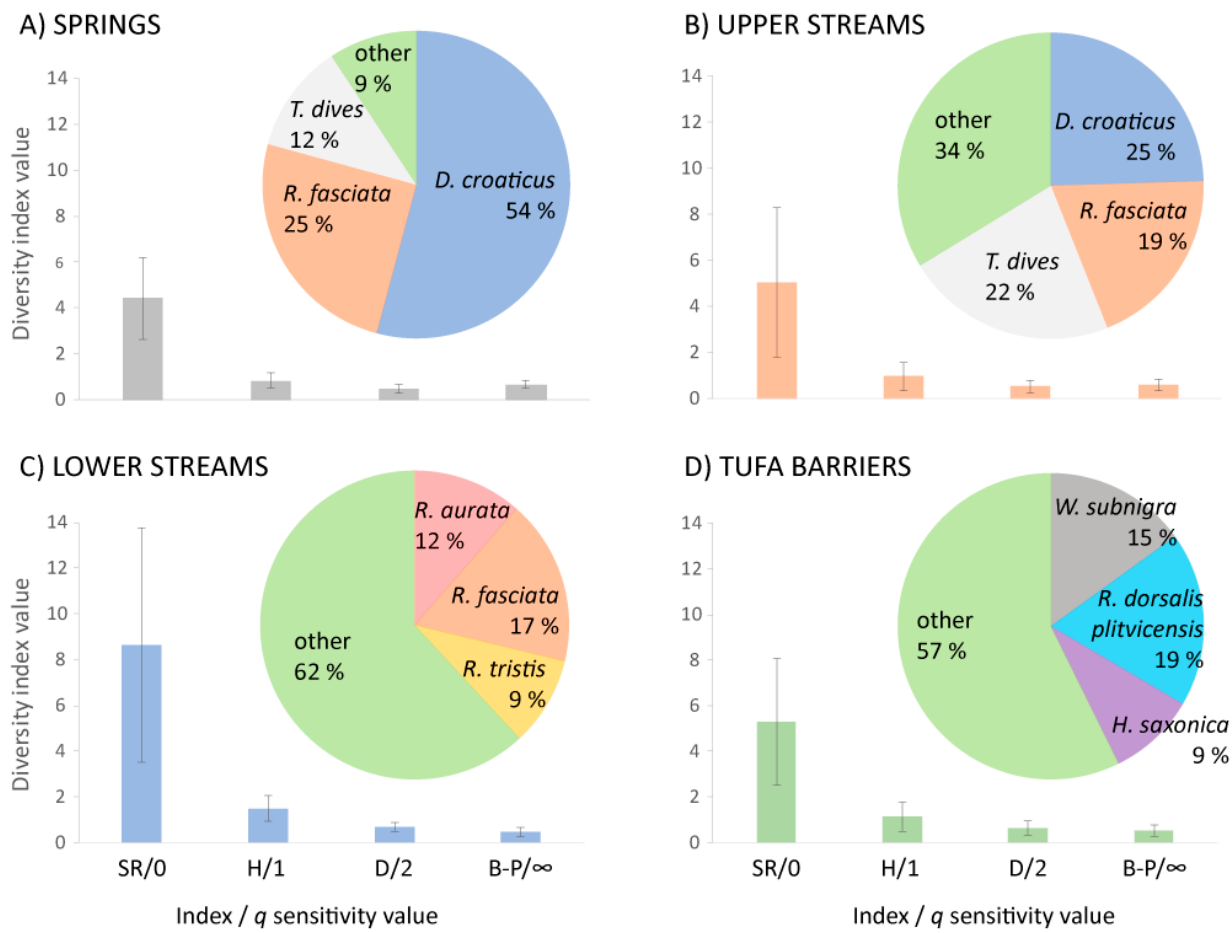
Figure 3. “Classical” (i.e., most commonly used) similarity profiles with values (average ± SD) of familiar diversity indices on a disjunct gradient of the sensitivity parameter q shown for each habitat type: ( A ) springs; ( B ) upper streams; ( C ) tufa barriers; ( D ) lower streams. SR = species richness, H = Shannon index, D = Simpson index, B-P = Berger-Parker index. The top three species primarily responsible for the observed similarity within habitat groups (as defined by SIMPER analysis), as well as their ratios of contribution to group similarity are also shown for each habitat type.